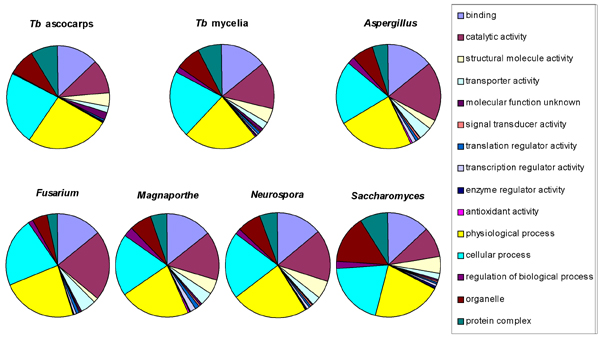
Pie representation of the ontology occurrences. Distribution of the matching ontologies in the second-level GO categories for the different considered organisms. Only GO categories where at least one of the organisms had a percentage of matches > 1 were included in pies.